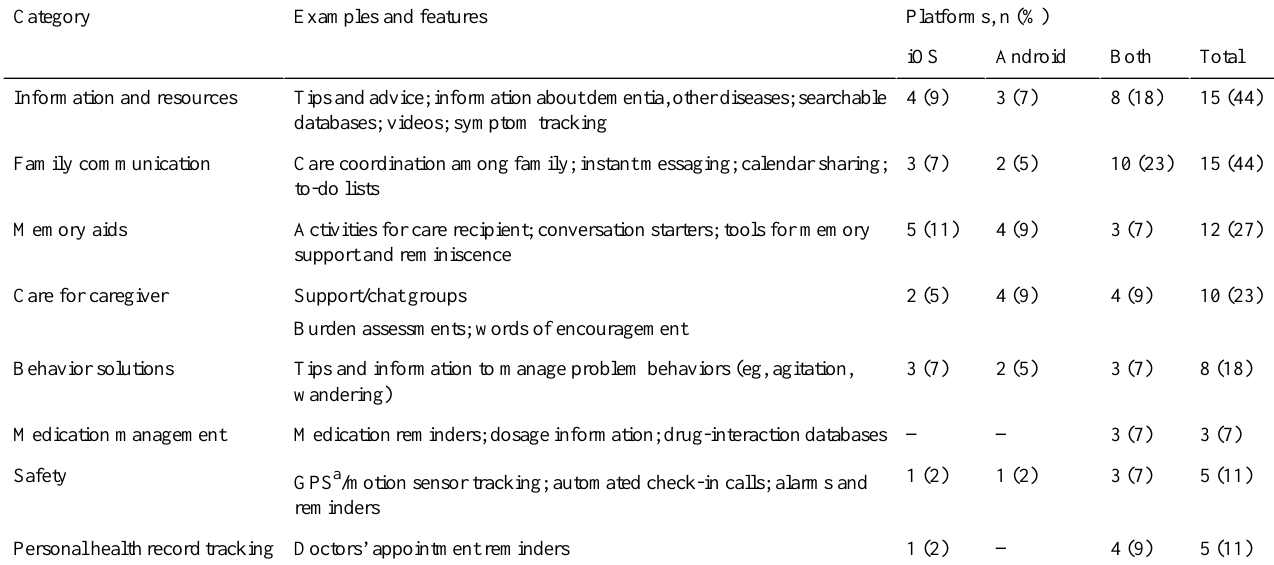
Platforms, n (%)Examples and featuresCategory TotalBothAndroidiOS